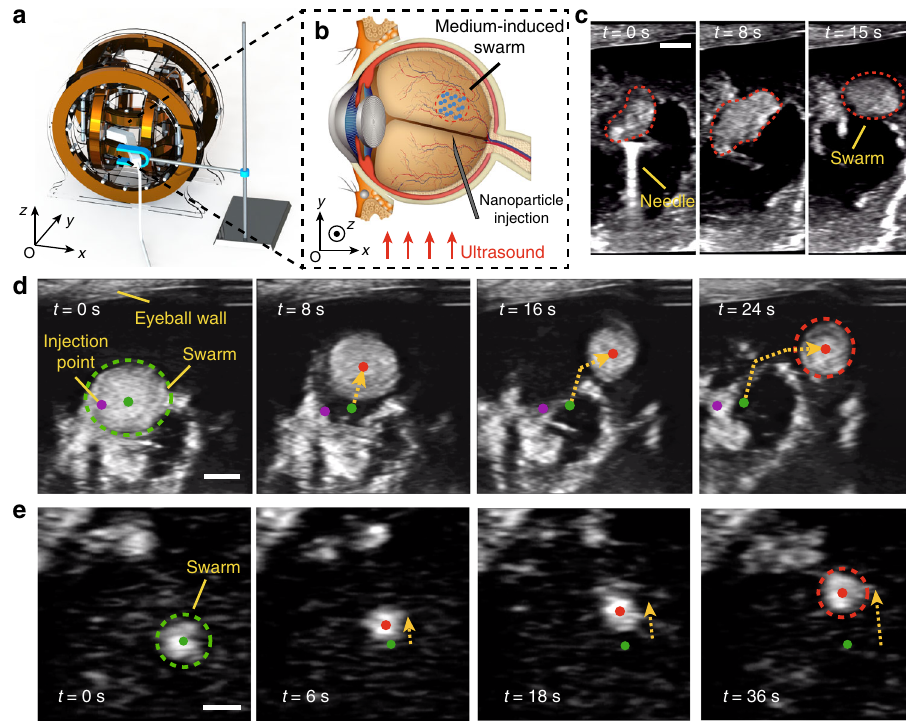
Fig. 8 Ex vivo validations of the generation and actuation of medium-induced swarms in bovine eyeballs. a The schematic demonstration of our experimental setup. An ultrasound transducer is integrated onto the Helmholtz electromagnetic coils. A bovine eyeball is placed in the workspace. b A schematic illustrating the navigated locomotion of a medium-induced swarm in vitreous. c The generation process of a swarm after the injection of nanoparticle suspension using a syringe. The pattern of the nanoparticles is inclosed by red dashed curves. The scale bars indicate 1 mm. d The targeted locomotion of a large-size swarm. The scale bars indicate 2 mm. e The targeted locomotion of a relatively small-size swarm. The scale bars indicate 800 μ m. The original pattern and the centre are indicated using a green dashed ellipse and a green spot, respectively. The injection point is indicated by purple spots. The current centre of the swarm is presented by red spots, and the trajectories of the locomotion are indicated using yellow dashed